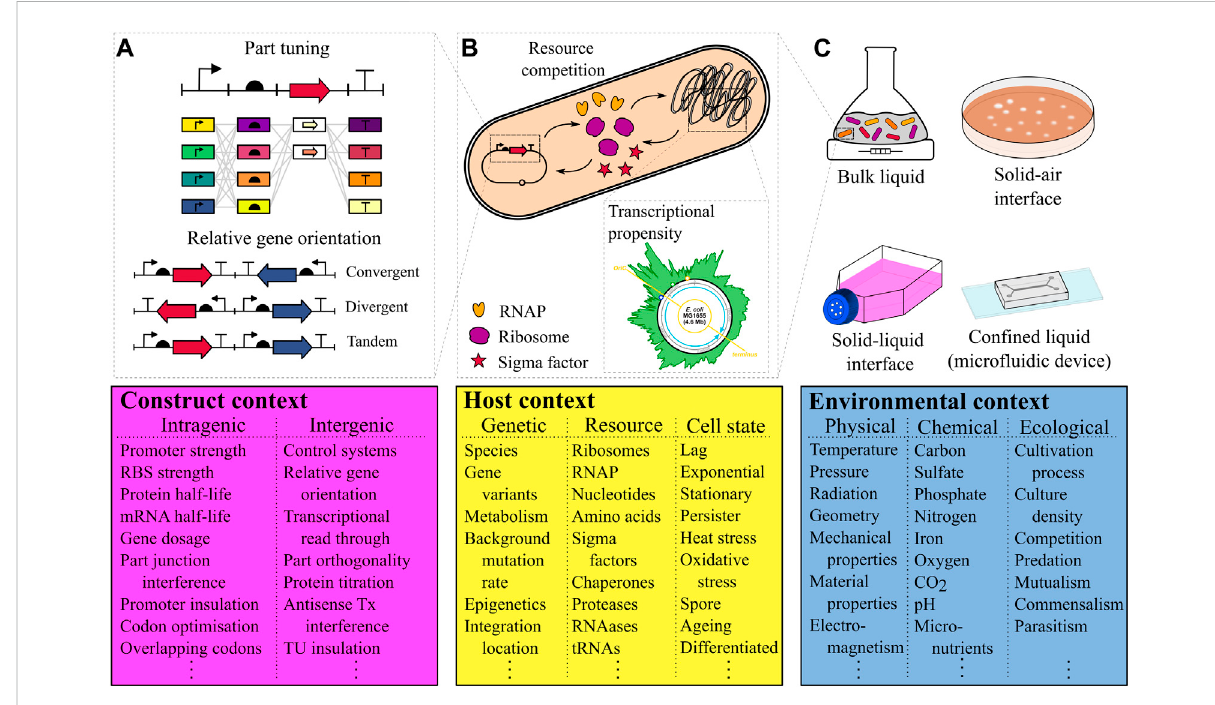
FIGURE 1 The three contexts of an engineered biosystem ’ s function (A) Construct context includes factors intrinsic to the design of thesynthetic genetic circuitwhichcanaffectperformance,andcanbebroadlydividedintointraandinter-transcriptionunitconstructcontexts.Anexampleofanintra-TU contextisthecompositionoftheconstruct itself,which canbetunedwithdifferentpartstoachievedifferentoutputs.Relativegeneorientationisan example of an inter-TU context, which can signi fi cantly affect expression (Yeung et al., 2017). (B) The host context concerns all factors where the host organism affects the performance of the biosystem, and can be divided into the contexts of genetic factors, resource competition and the state in which the cell is growing. Resource competition (top, middle panel), is the phenomenon of a synthetic circuit competing with the host genome for shared resources. For genome-integrated circuits differing transcriptional propensities (indicated by the height of the green region) specify how the location of the circuit in the chromosome will affect performance (Scholz et al., 2019). (C) The environmental context in which the biosystem operates is de fi ned by physical, chemical and ecological factors (reducing to just physical and chemical factors for cell-free systems). A selection of cultivation processes are illustrated, the differences between which are likely to have signi fi cant effects on gene expression in individual cells and shape the growth of thepopulation as awhole. Acroynms:TU = transcriptionunit. RNAP = RNA polymerase. RBS = Ribosomalbinding